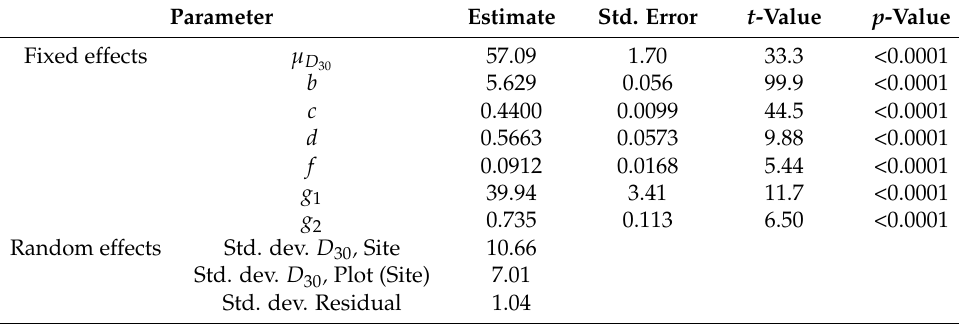
Table 6. Parameter estimates of common asymptote Korf DBH model with stand density adjustment (Equation